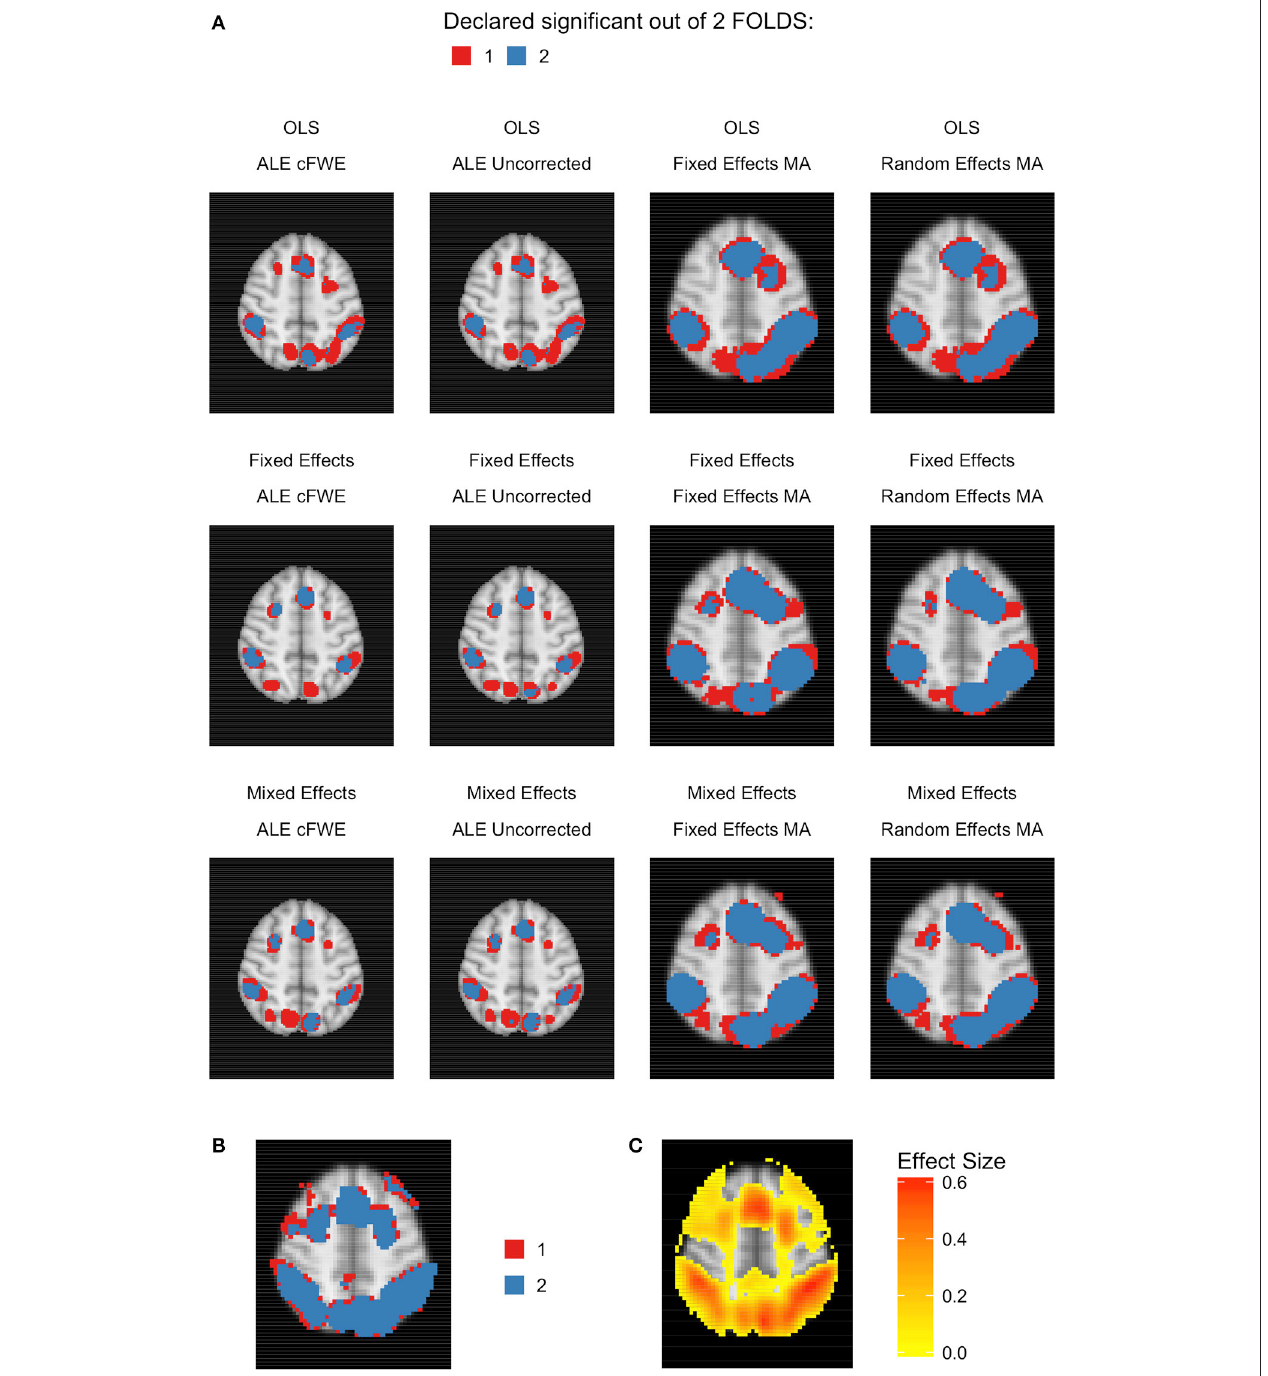
FIGURE 13 | Heatmap of MNI z-coordinate 50 for K 35. (A) The number of folds in which each voxel has been declared statistically significant for each combination = of a group level model (row-wise) and thresholded meta-analysis (column-wise). Note that the resolution of the images corresponding to the analyses within either ALE or the fixed and random effects CBMA is different (see main text). (B) The number of folds in which each voxel of the reference images has been declared statistically significant. Areas of interest involve the supramarginal gyrus (posterior division), superior parietal lobule and angular gyrus. (C) Average effect size of the reference images over the